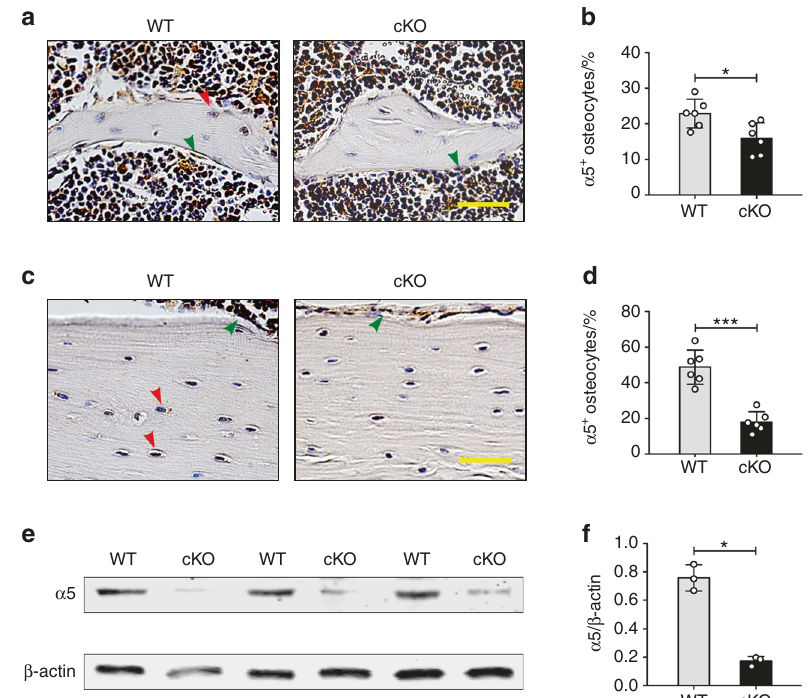
Fig. 1 Deletion of integrin α 5 gene in osteocytes, but not in osteoblasts in cKO mice. Representative images of integrin α 5 immunohistostaining in tibial metaphyseal trabecular bone ( a ) and midshaft cortical bone ( c ) of WT and cKO mice. The red arrow shows α 5-positive osteocytes and the green arrow shows α 5-positive osteoblasts. ( a , c ) Scale bar: 40 μ m. Quanti fi cation of integrin α 5-positive osteocytes in tibial trabecular bone ( b ) and cortical bone ( d ) of WT and cKO mice. n = 6 per group. e , f Integrin α 5 deletion was con fi rmed by western blot of marrow- fl ushed tibia bone extract samples. n = 3 per group. Mean ± SD. * P < 0.05; *** P < 0.001. Student unpaired t